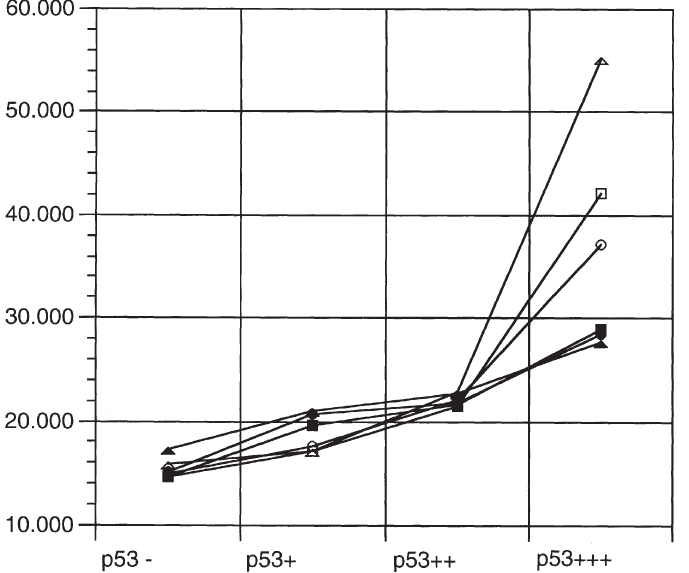
Fig. 3. Standard deviation of integrated optical density (S.D. IOD) in nuclear populations with different p53 expression in correlation to the tumour size and the lymph node status. p53 − . . . p53 negative nuclei; p53 + . . . weakly positive nuclei; p53 ++ . . . moderately positive nuclei; p53 +++ . . . strongly positive nuclei. 1 pT1; 2 pT2–4; ! pN0; " pN1–2; P pT1pN0; Q pT2–4pN1–2.